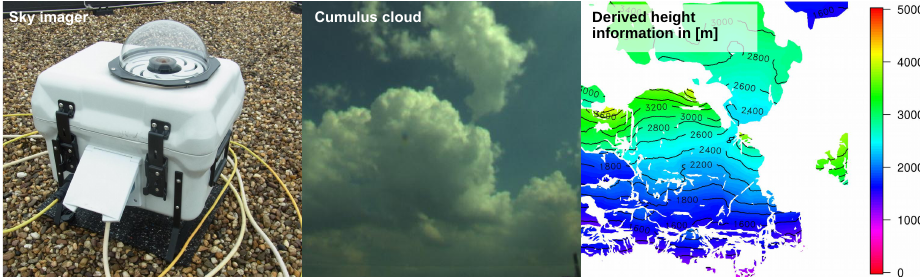
Figure 1. We employ two hemispheric sky imagers (left) in a stereo setup with a baseline of 300m to derive dense and detailed geometric information, such as height and morphology of clouds, within a range of about 5km using the simultaneously recorded image pairs. The derived heights (right) of an exemplary recorded cloud (middle) using the fisheye images, as shown in Fig. 4c, of the two sky